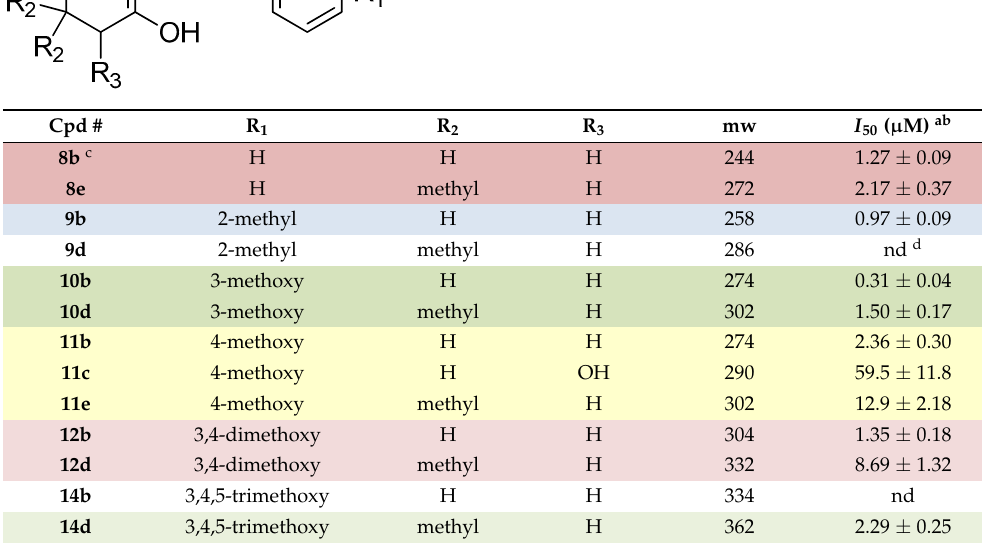
Table 2. Structures and activities of 17 cyclohexane-1,3-diones with phenyl side chains tested in this study.